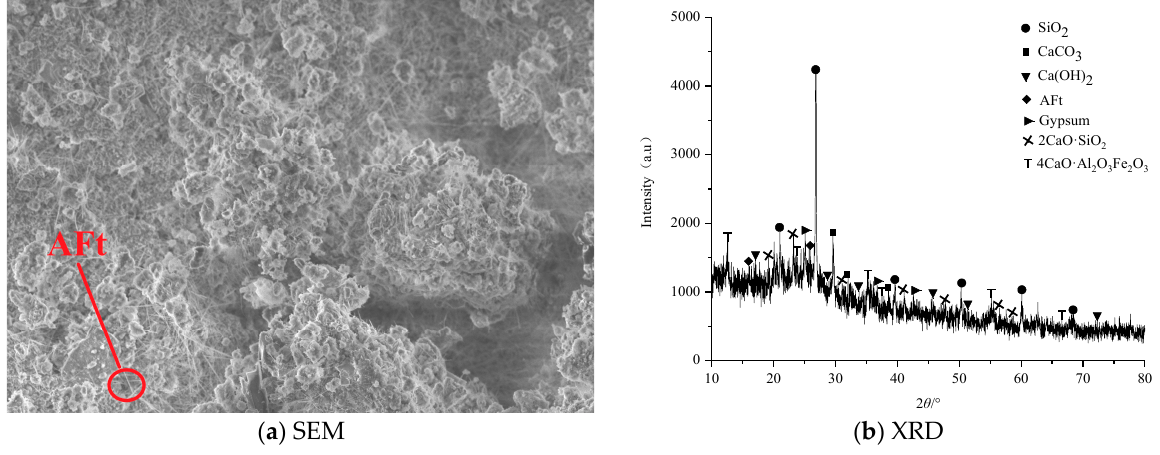
Figure 4. SEM image and XRD pattern of T1 specimen.